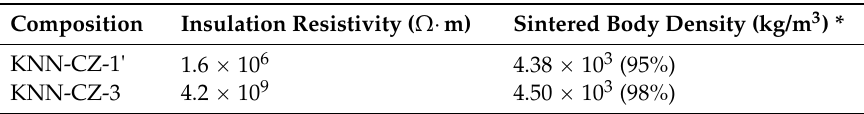
Table 4. Insulation resistivity and sintered body density of KNN-based multilayer samples (measured temperature: 25 ˝